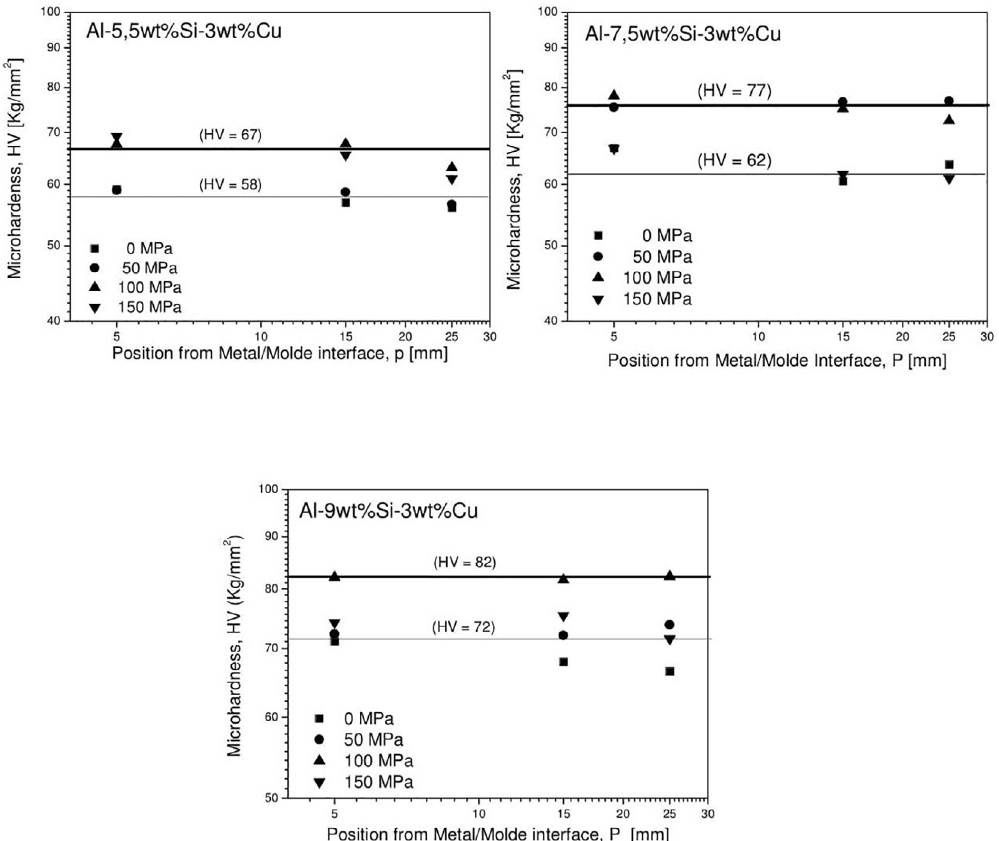
Figure 8. Microhardeness dependence as a function of position from metal/mold Interface. (a) Al-5,5%wtSi-3%wtCu, (b) Al-7,5%wtSi-3%wtCu e (c)